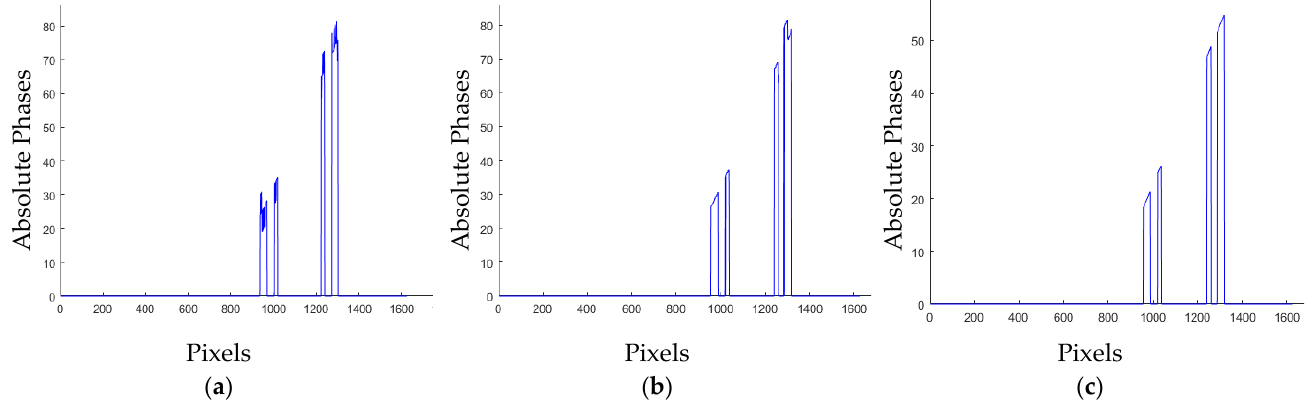
Figure 5. Absolute phase of flange acquired by different methods. Traditional method ( a ). Method of [15] ( b ). Method of this paper ( c ).